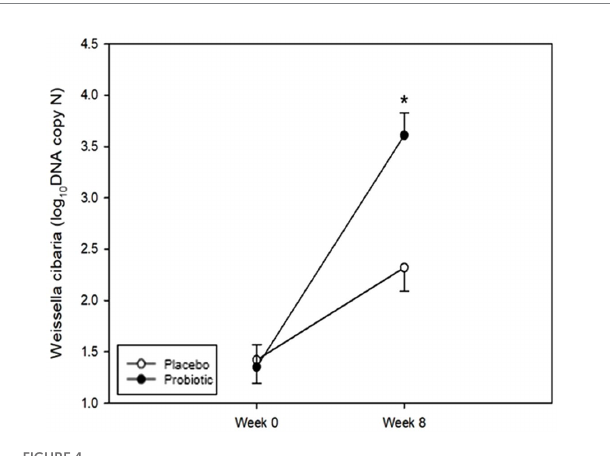
FIGURE 4 Changes in Weissella cibaria. The levels of W. cibaria were not significantly different between the groups at week 0 ( p = 0.619). The levels of W. cibaria were significantly higher in the probiotic group than in the placebo group at week 8 ( p < 0.001). Each line represents the LSmean ± SE. *Value of p ≤ 0.05, Student’s t -test.